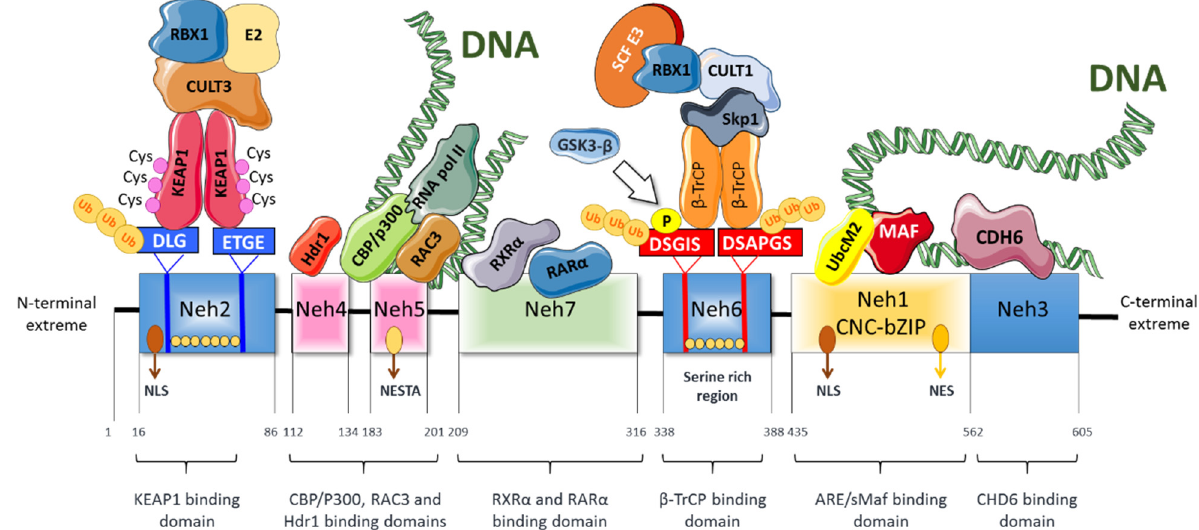
Figure 1. Schematic structure of Nrf2. Nrf2 has seven highly conserved domains (Neh1-Neh7). Among these domains, Neh2 is the Keap1-binding domain. Neh6 is important for binding to the negative regulator β -TrCP. Both Neh2 and Neh5 are responsible for Nrf2 ubiquitination and degradation. Neh1 contains a cap‘n’collar basic-region leucine zipper domain that is important for interacting with sMAF proteins and DNA, and is also required for the nuclear translocation of Nrf2. Neh3, Neh4, and Neh5 domains are necessary for transactivation. Neh7 is necessary for binding with the RXR α .